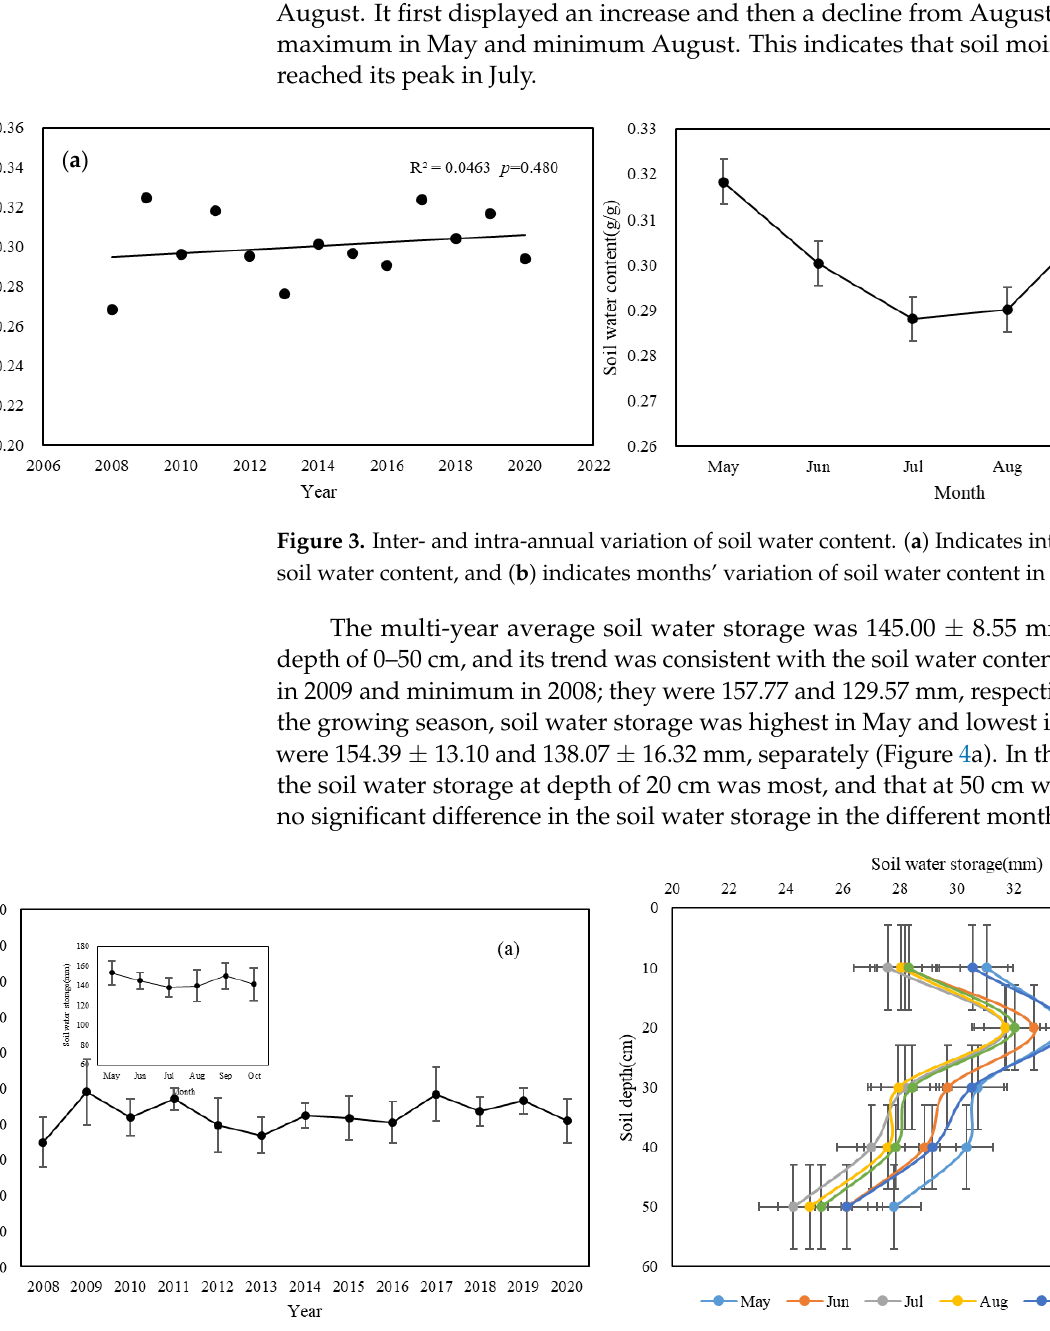
Figure 4. Inter- and intra-annual variation of soil water storage. ( a ) Indicates interannual variation of soil water storage, and ( b ) indicates months’ variation of soil water storage in growth season.